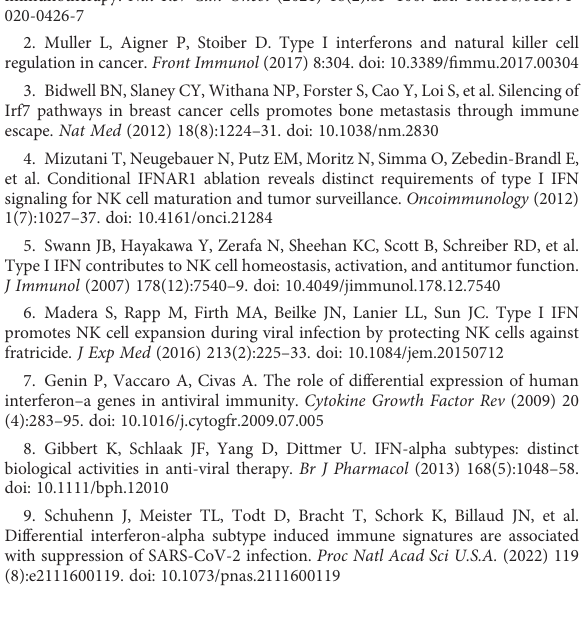
IFN-I Activation of NK Cell Function. PBMCs from 50 healthy donors were either left unstimulated or were stimulated with 100 IU mL -1 of each IFN ⍺ subtype or IFN b overnight. Following overnight activation, cells were washed and then co-incubated with K562 cells for 5 hours at a 2:1 E:T ratio and NK cell effector functions were assessed. (A) Representative gating strategy. NK cell function was assessed as the percentage